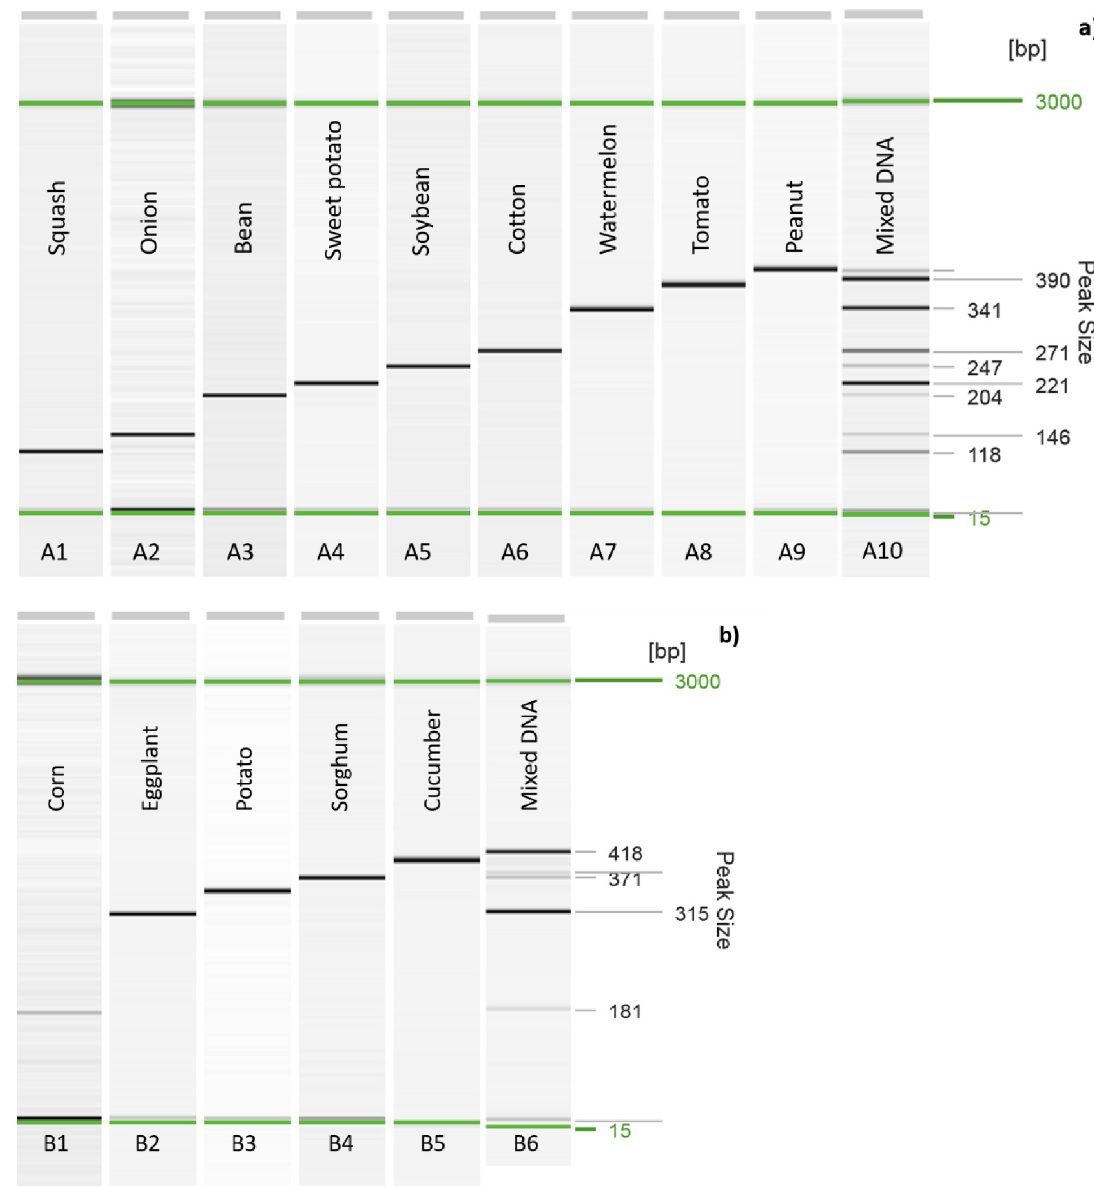
Fig 1. The amplification of the plant target DNA using two working multiplex primer mixes (primer mix 1 & 2, panel a & b) containing several species-specific primers and their associated amplicon sizes (bp). The PCR products were visualized on a QIAxcel Advanced system, and Qiagen alignment markers were employed to separate amplicon sizes ranging from 15bp to 3000bp. The plant species were ordered by expected base pair sizes, to indicate the expected ranges of band sizes using the designed primers. Panel a) consisted of the result of multiplex PCR on a single target species from left to the right A1-A9: Cucurbita pepo , Allium cepa , Glycine max ,